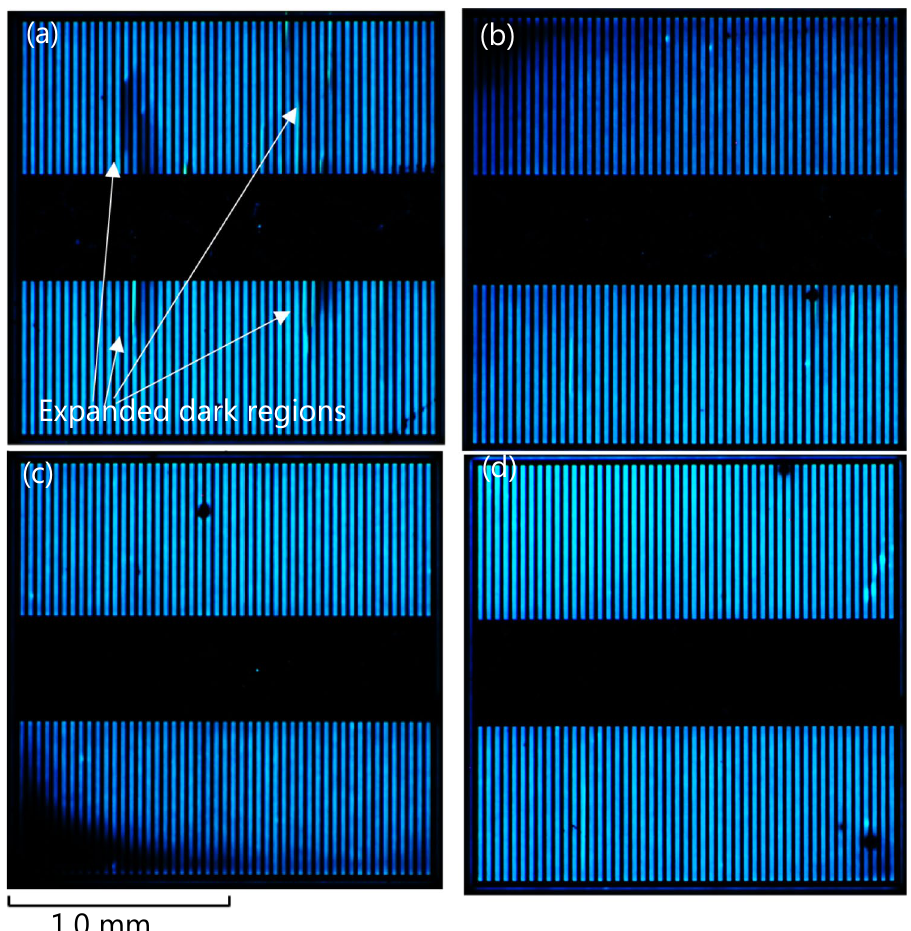
Figure 3. EL images of PiN diodes at 25 A/cm 2 after the electrical stress with 2 h for ( a ) without proton implantation and when implanted with ( b ) 10 12 cm −2 , ( c ) 10 14 cm −2 , and ( d ) 10 16 cm −2 doses of